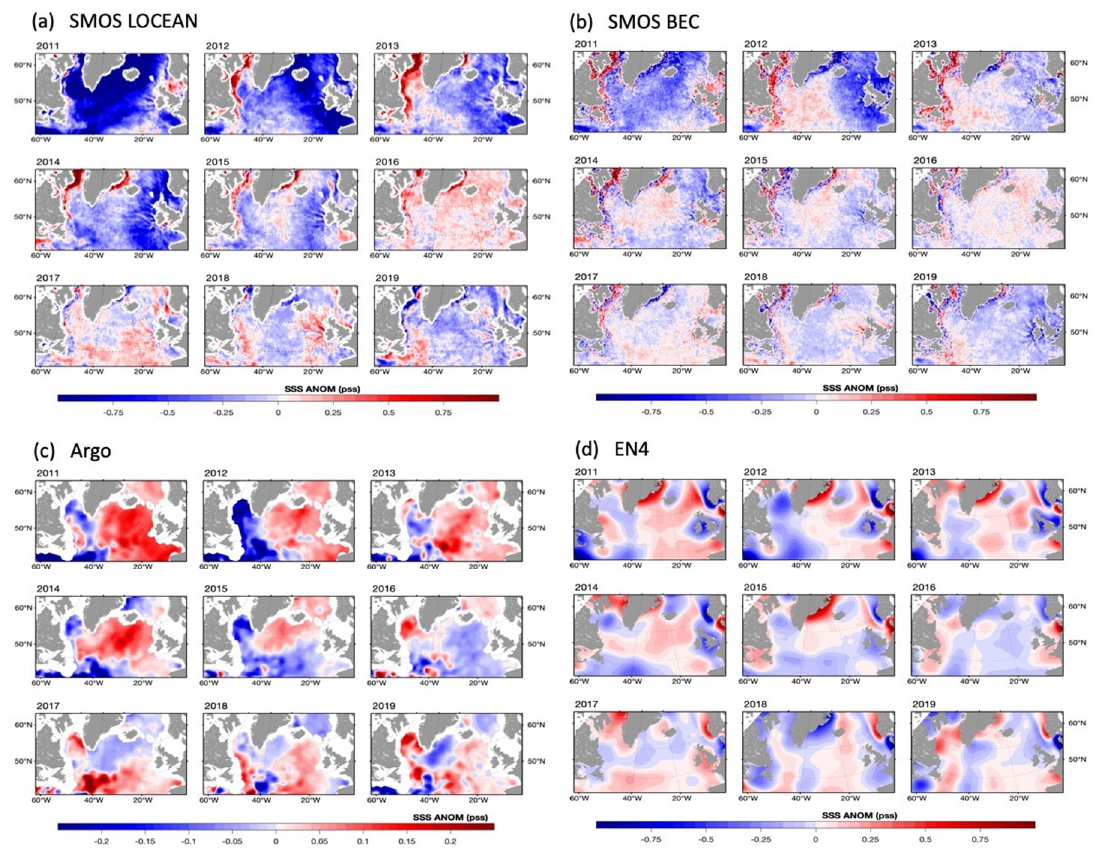
Figure 11. Year-to-year variations of the yearly mean SSS anomalies produced by ( a ) SMOS LOCEAN, ( b ) SMOS BEC, ( c ) Argo, and ( d ) EN4. The anomalies are referenced to the 2016–2018 mean. Note that the color scale ranges from -1 to 1 pss in ( a , b , d ) but is reduced to –0.25 to 0.25 pss in ( c ).